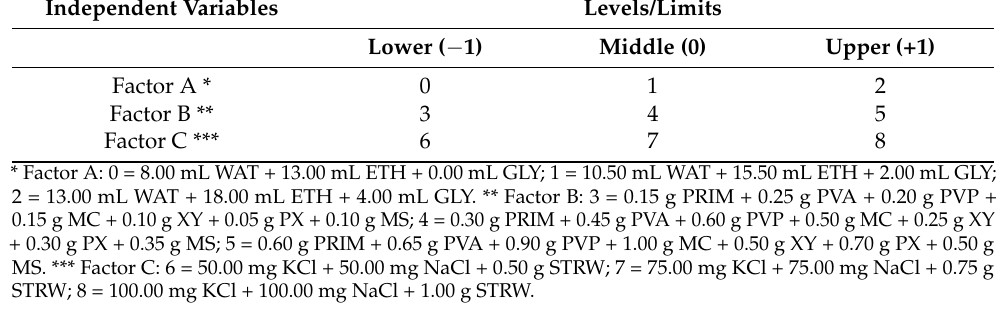
Table 1. Levels of independent variables utilized for the synthesis of the reconstitutable suspensions. Independent